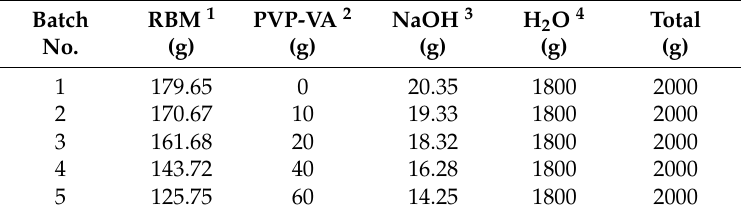
Table 1. Materials used for preparing granules using